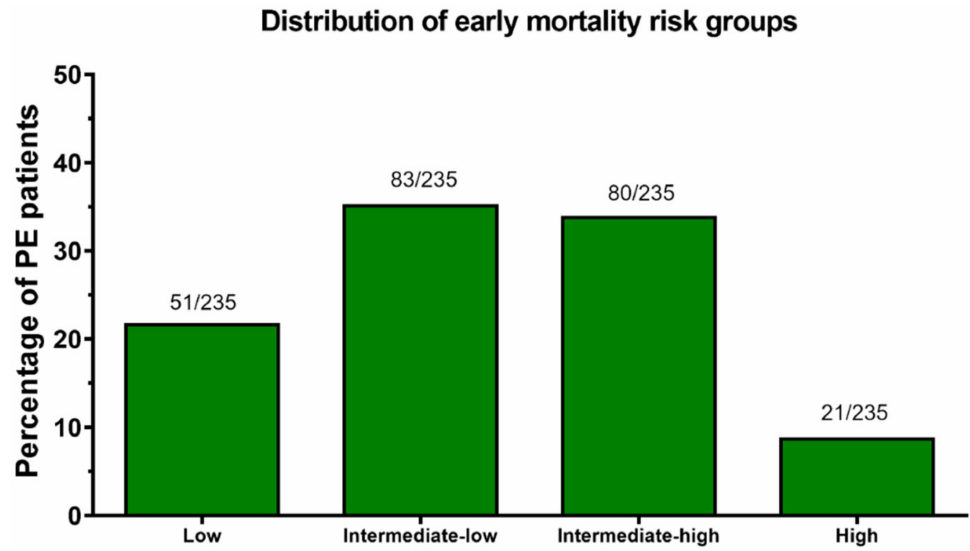
Figure 2. Distribution of the early mortality risk groups in the study population.